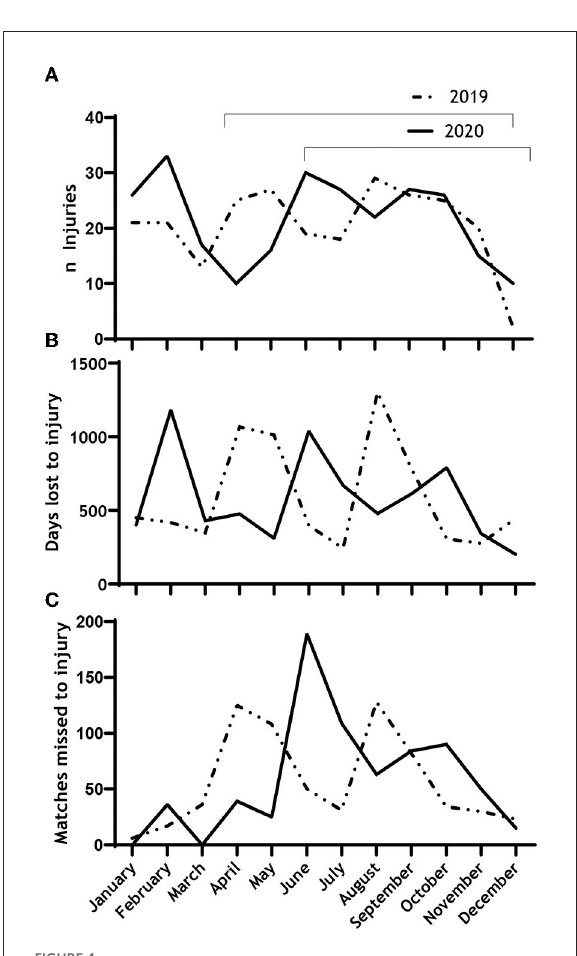
FIGURE4 Timeline of the monthly number of injuries (A) , days lost due to injury (B) and matches lost due to injury (C) across the two seasons, 2019 and